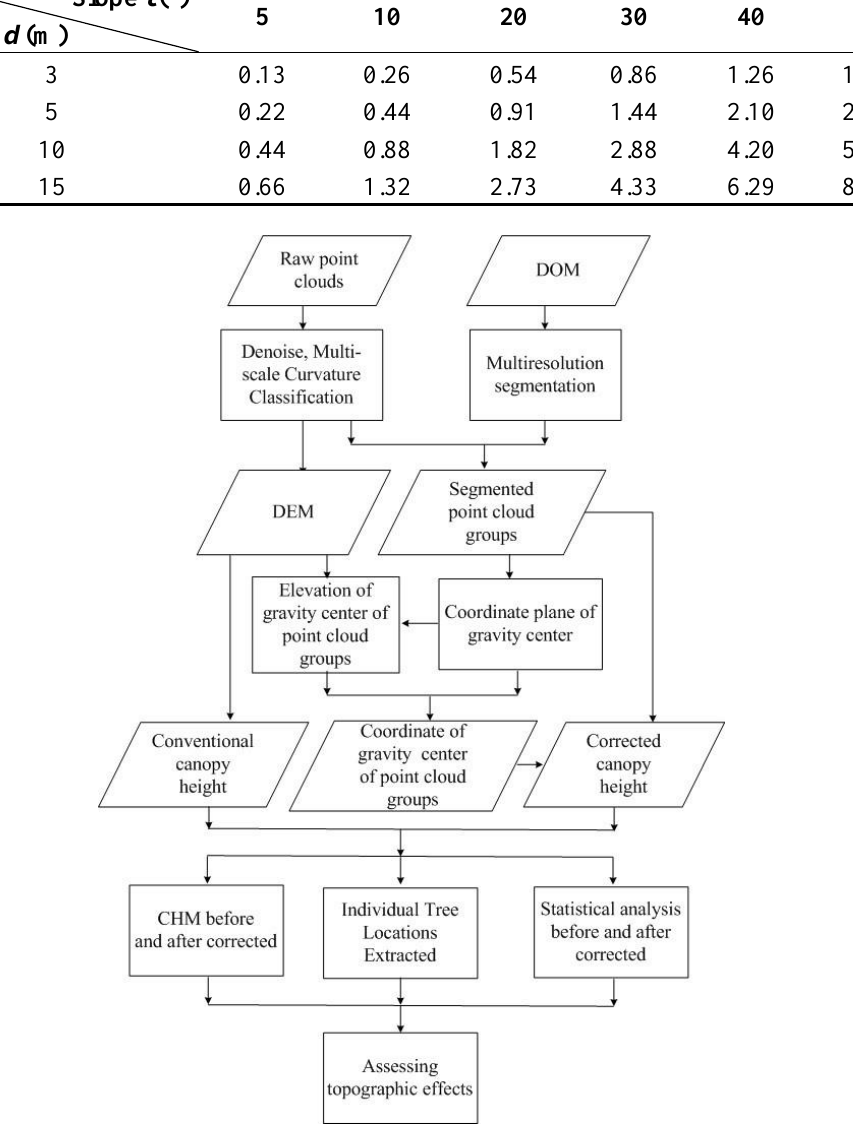
Figure 4. Flowchart of methods used in this